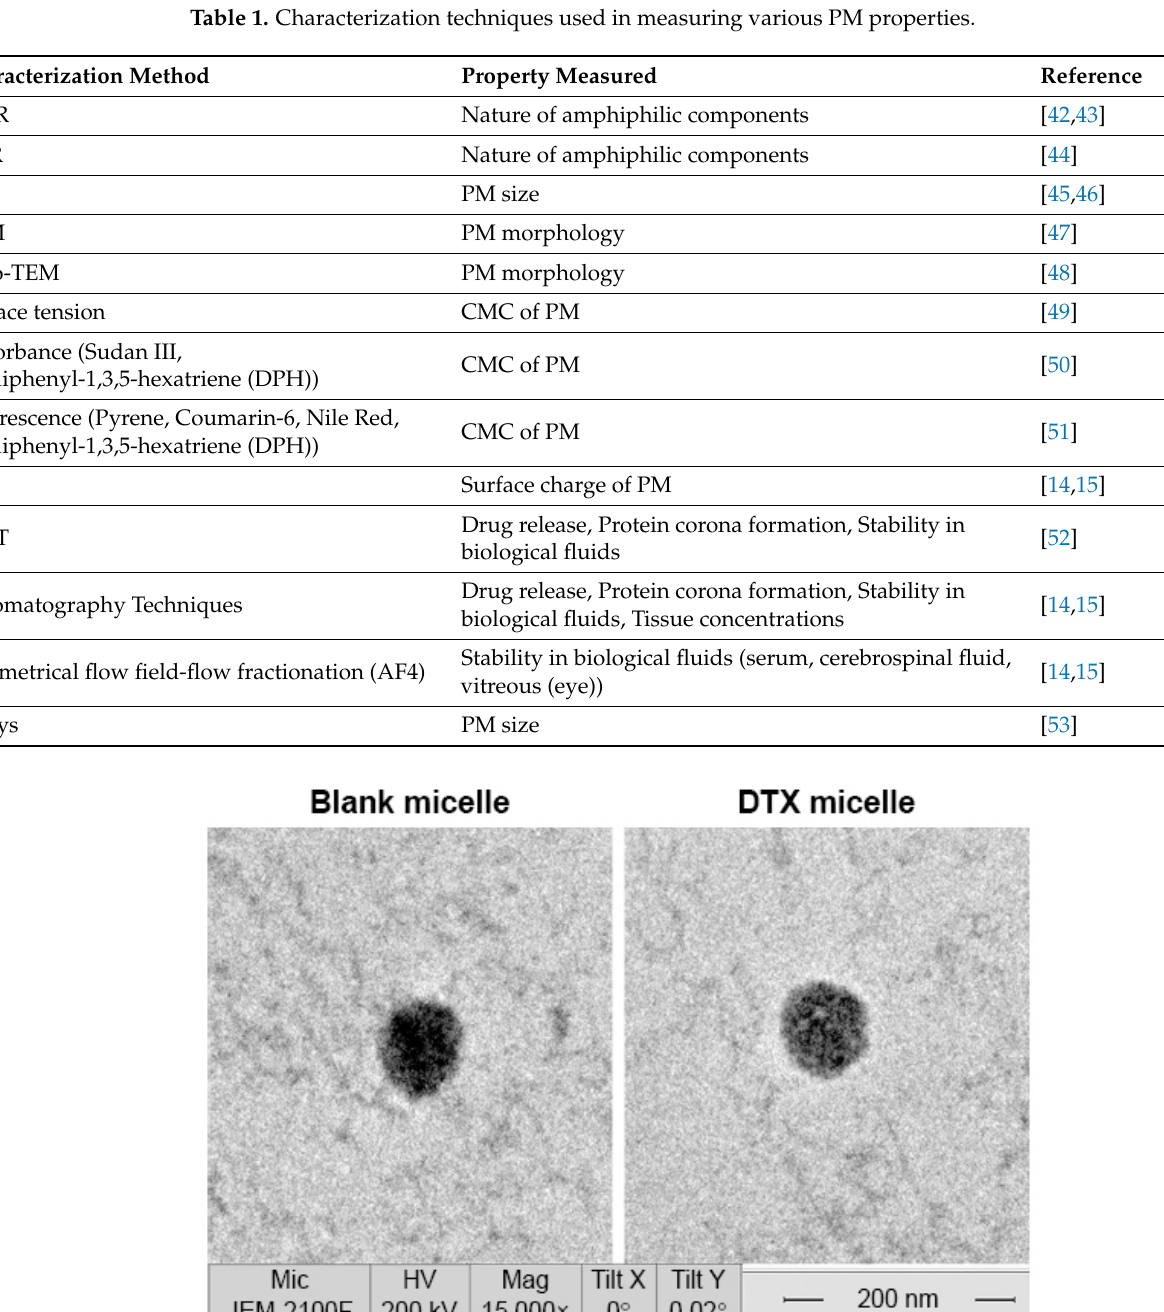
discussed, PMs are a simple assembly of amphiphiles at the CMC. This indicates that the structure formed is due to weak interactions and will fall apart when the CMC is altered, mostly upon dilution, thereby weakening the stability of the structure [37]. Therefore, the prime area of improvement is to design stable PMs that are stable enough upon admin- istration in the bloodstream. Stable PMs will help prevent any premature leakage out of the encapsulated drugs, thus increasing the circulation half-life and helping to improve